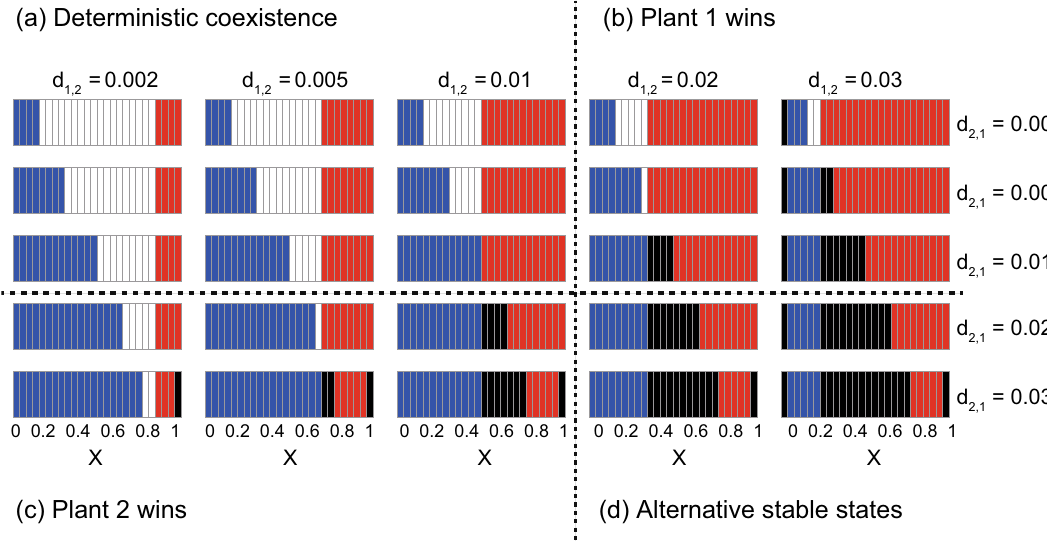
Figure 3. Results of the asexual model showing the effects of visiting preference on inter-plant competition and coexistence for different rates of density-dependent plant death. The horizontal axis in each panel represents the visiting preference on plant 1. The notations are the same as those in Fig.